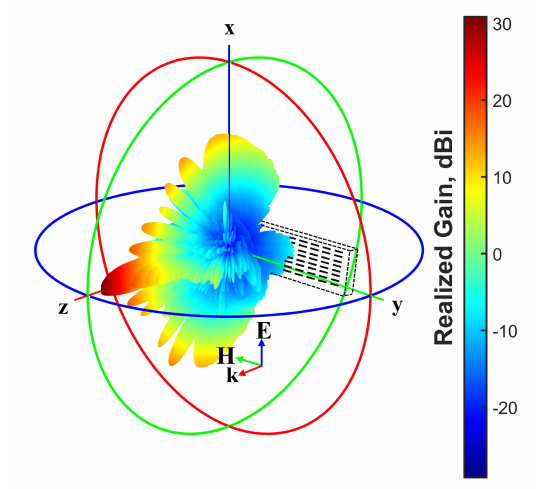
FIGURE 5. Measured 3-D pattern of the antenna at 24.5 GHz.